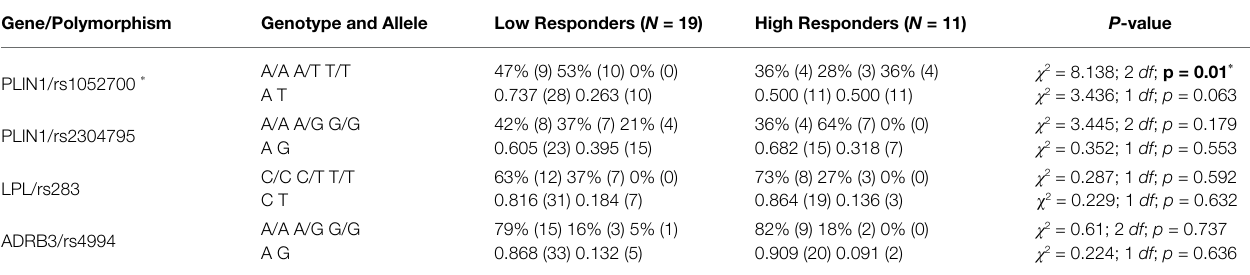
TABLE 4 | Genotype distribution and relative allelic frequencies for studied lipid metabolism-related polymorphisms by low and HiRes to fat mass reduction after the 12-week intervention ( N = 30).